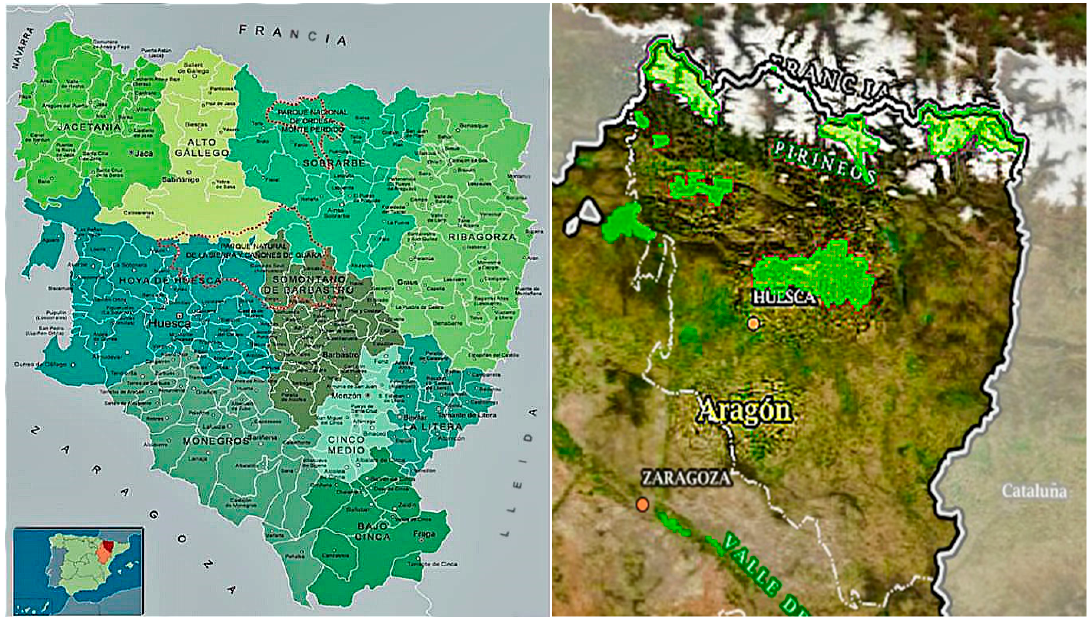
Figure 1. Comarcas in Huesca and location of Huesca province in Spain and in the autonomous community of Aragon ( left ), Source: [52]; Protected areas in the Huesca province ( right ), Source: [49].